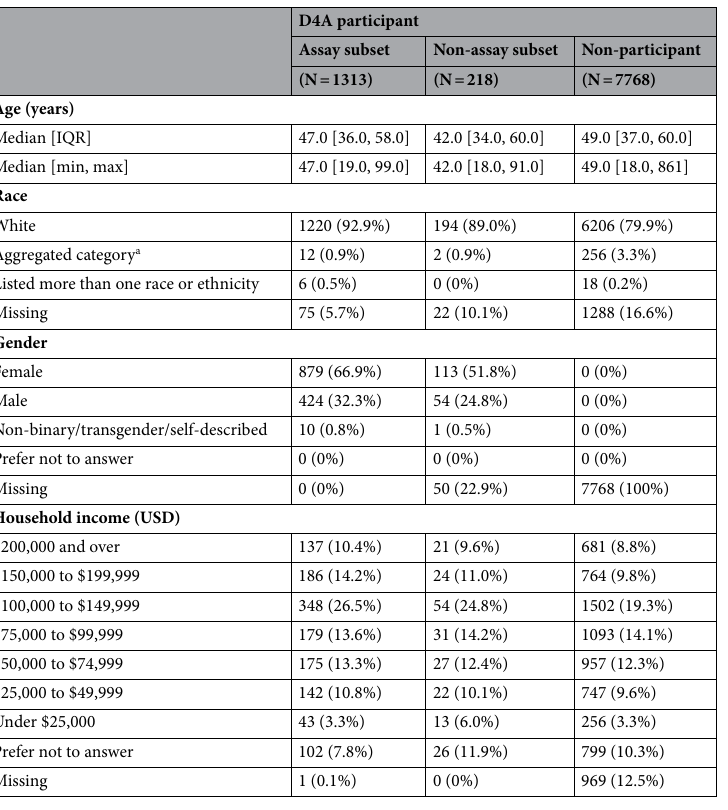
Table 1. Demographic characteristics of study participants. Non-D4A participants are all participants in the initial anonymous survey from which Data4Action participants were drawn. D4A participants are divided into subsets for which antibody assays were conducted (N = 1313) and those for which assays were not conducted (N = 218). a Asian; Hispanic, Lantino/a, or Spanish; Black or African American; Middle Eastern or North African; Native American or Alaska Native; other race or ethnicity. This category is aggregated to protect participant identities because no single group comprised > 4% of